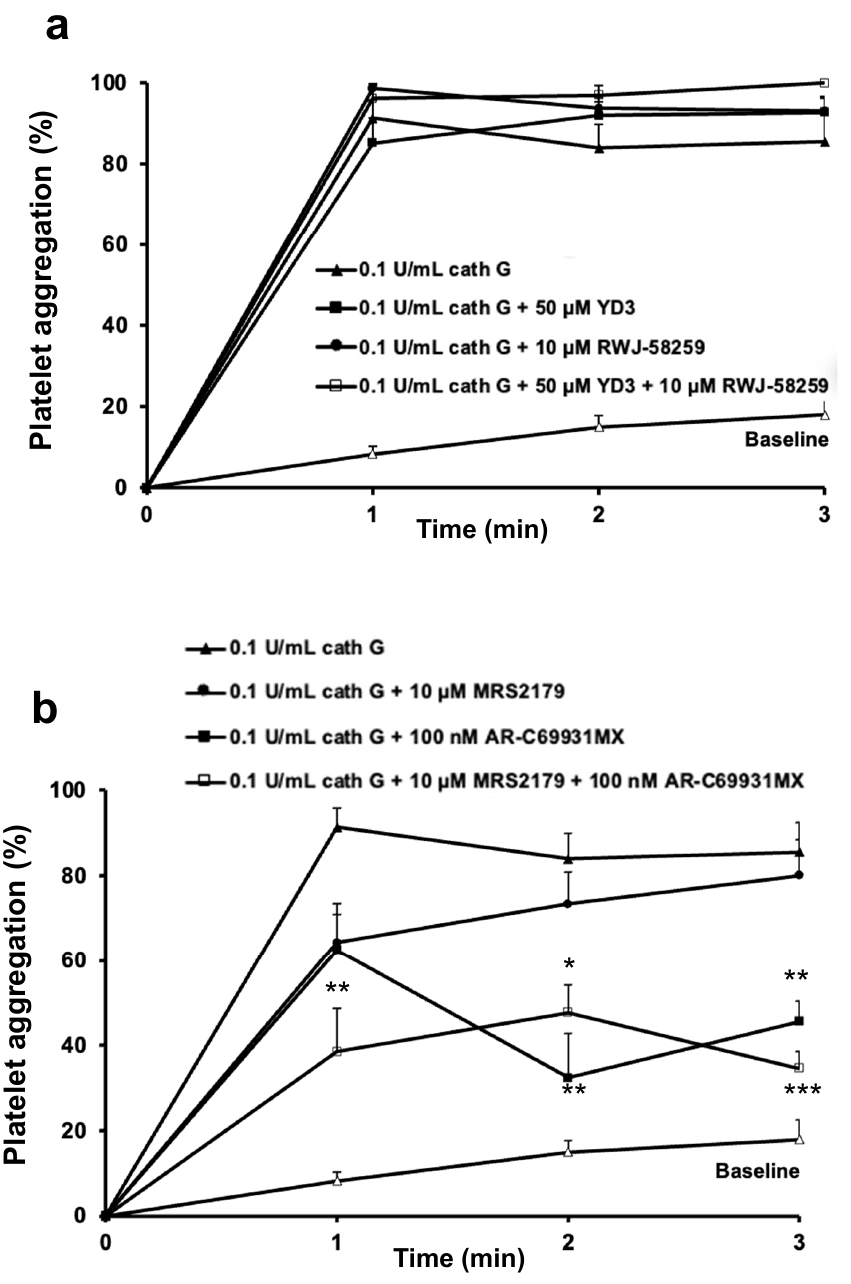
Figure 3. Human whole blood aggregation: role of ADP. ( a ) Platelet aggregation curves in human blood, without agonist (Baseline, open triangles), or upon addition of 0.1 U/mL cathepsin G (cath G), in the absence or the presence of the PAR1 antagonist RWJ-58259, the PAR4 antagonist YD-3 or their combination, at the concentrations indicated in the insert. ( b ) Platelet aggregation curves in human blood, without agonist (Baseline, open triangles), or upon addition of 0.1 U/mL cathepsin G (cath G), in the absence or the presence of the P2Y 1 and P2Y 12 receptor antagonists MRS2179 and AR-C69931MX, respectively, or their combination, at the concentrations indicated in the insert. Data are mean ± SEM ( n = 3 in each group). Statistical analysis was by one-way ANOVA, followed by Newman–Keuls multiple-comparison test (* p < 0.05, ** p < 0.01, *** p < 0.001 vs. tracing for 0.1 U/mL cathepsin G). Platelet aggregation is calculated from residual platelet numbers at the indicated time